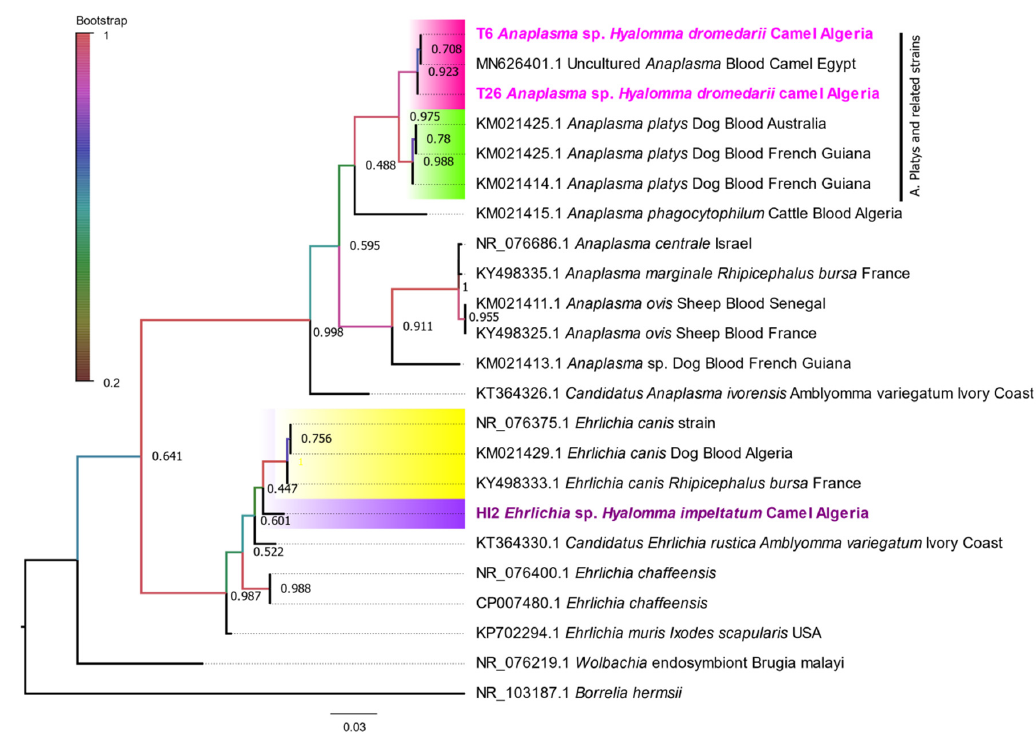
Figure 6. Phylogenetic tree of the 23S rRNA gene using the maximum likelihood method. The values on the branches are bootstrap support values based on 500 replications. The position of the obtained sequence is indicated in bold. The subcluster of A. platys is colored in green, and the subcluster of the sequences obtained is colored in rose. The subcluster of the obtained sequence of Ehrlichia is colored in purple. Borrelia hermsii was used as an outgroup.